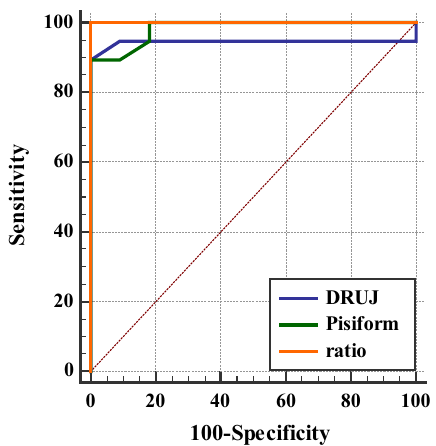
Fig. 5 ROC curve for the diagnostic performance of ADC at DRJU level